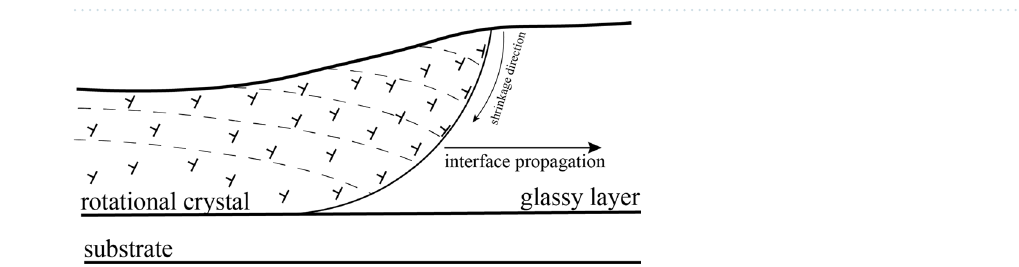
Figure 5. Schematic of the dislocation model of rotating crystal fiber growth from an amorphous film to explain the stress accommodation that takes place at the interface between low-density glass and high-density crystalline α -Quartz, based on ideas from 8, 9 . Dashed lines represent the bent lattice